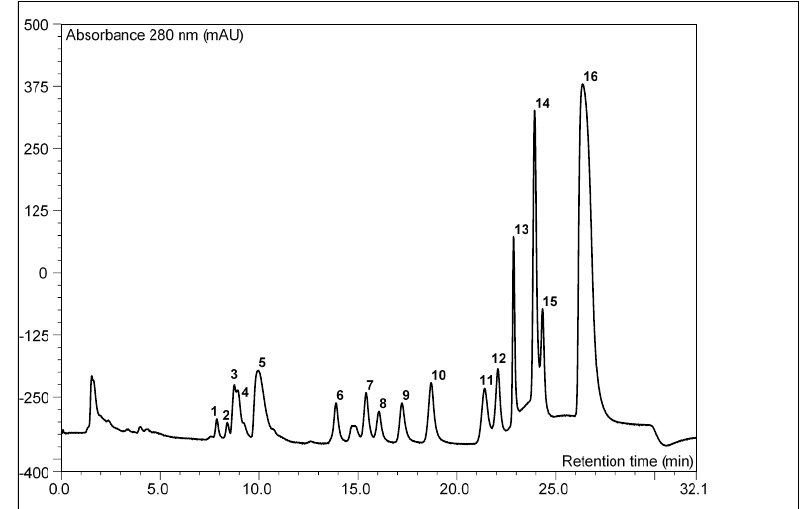
Figure 2. Exemplary high-performance anion-exchange chromatography (HPAEC) chromatogram of inositol phosphate profile of fermented pumpkin oil-cake (48-h fermentation with Rhizopus oligosporus